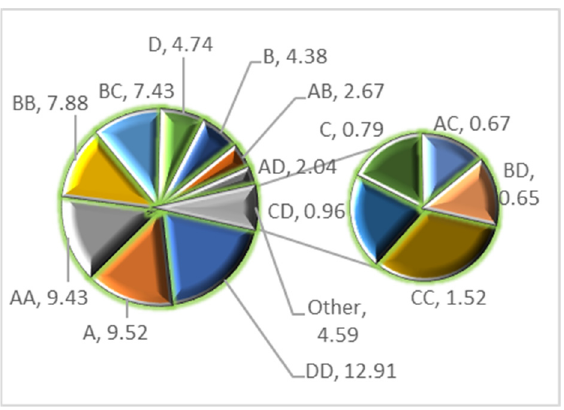
Figure 5. Pareto chart showing the significance of the factors and their combinations.